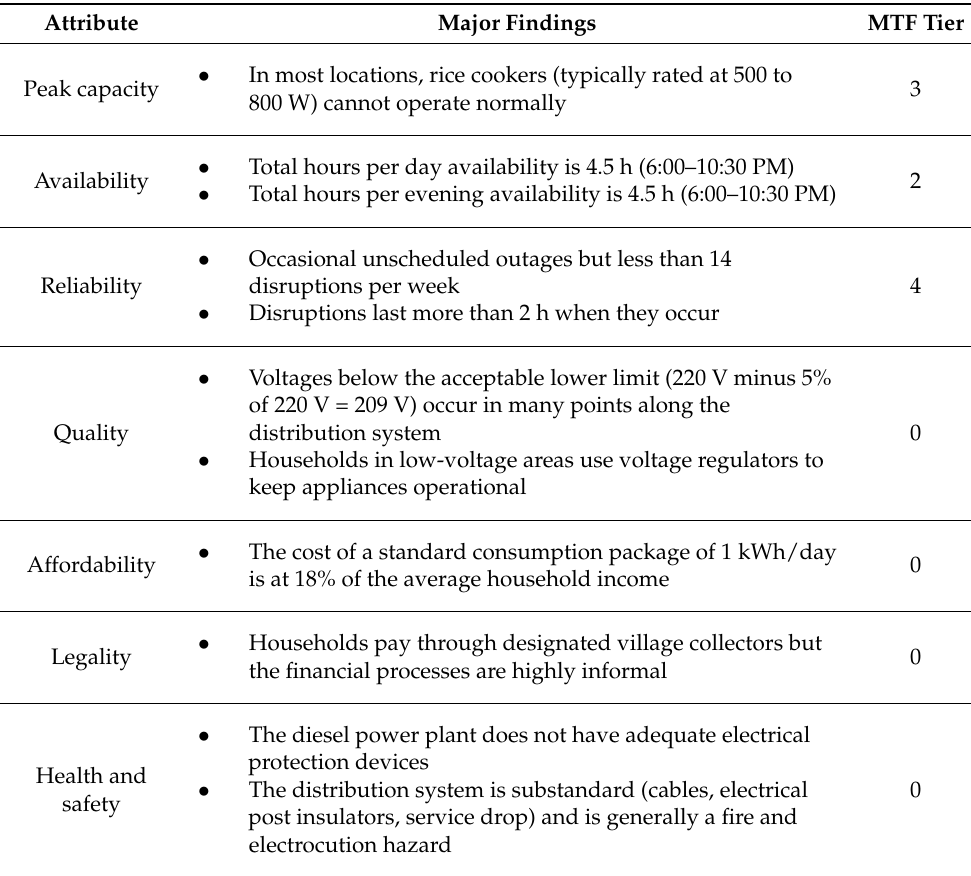
Table 7. Description of the electricity access on Gilutongan Island based on the multi-tier